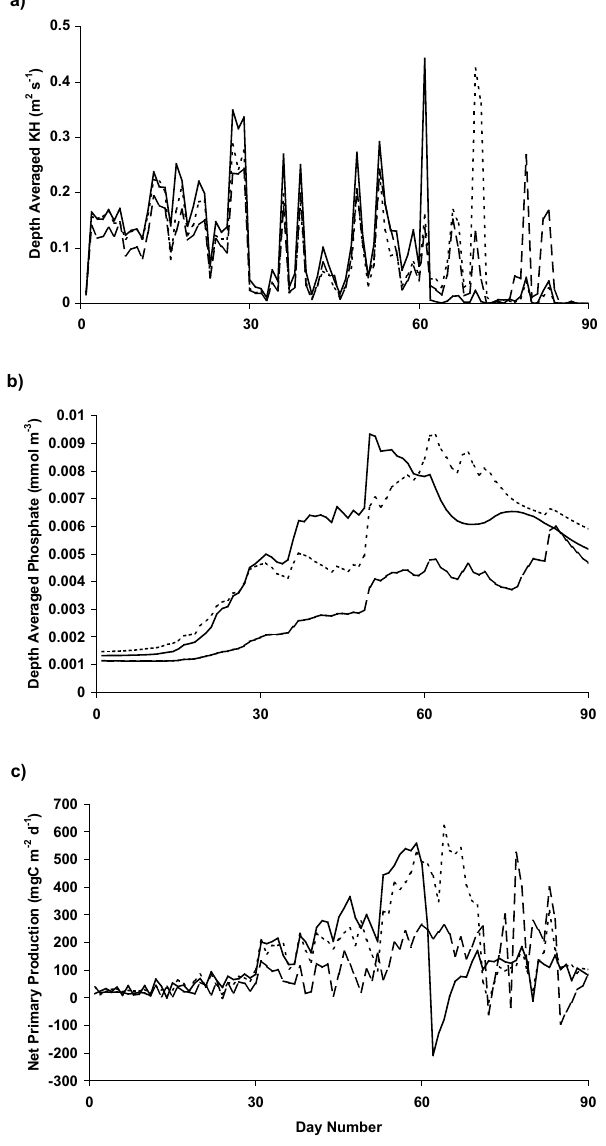
Fig. 12. Comparison of (a) vertical diffusion coefficient, depth av- eraged over whole water column (250m), (b) phosphate concentra- tion, depth averaged over the euphotic zone (surface 120m) and (c) the depth integrated primary production over the whole water col- umn, for the PA1 (large dashes), PA2 (small dashes) and PA3 (solid line)